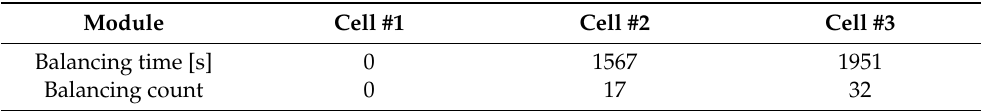
Figure 7. Experimental results from module #3. Table 7. Balancing parameters from module